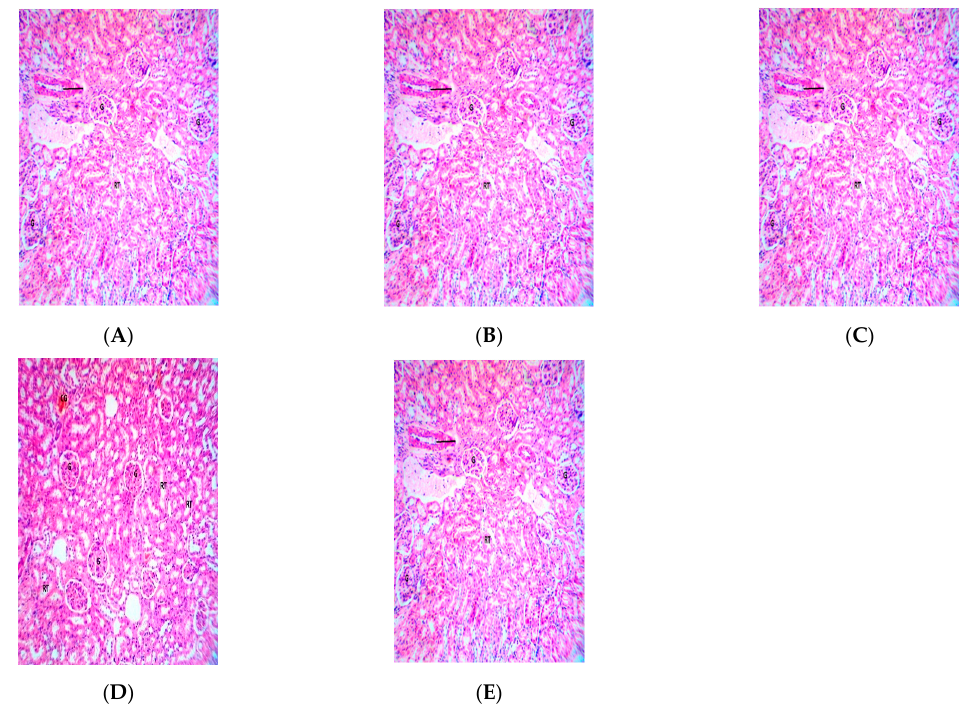
( E ) Figure 7: Photomicrograph shows the heart of Wistar rats repeatedly dosed with ( A ) 62.5 mg/kg bw, ( B ) 125 mg/kg bw, ( C ) 250 mg/kg bw, ( D ) 500 µg/kg bw P. dactylifera essential oil and ( E ) control. Cardiac muscle (CM) arranged in bundle, the nucleus (N) and branches of the coronary vessel (star) are normal (×400 H and E Staining). 3. Discussion Phoenix dactylifera L., called the ‘Tree of Life’ by the Arabs, is considered one of the oldest cultivated fruit trees, which has accompanied the development of early human so-